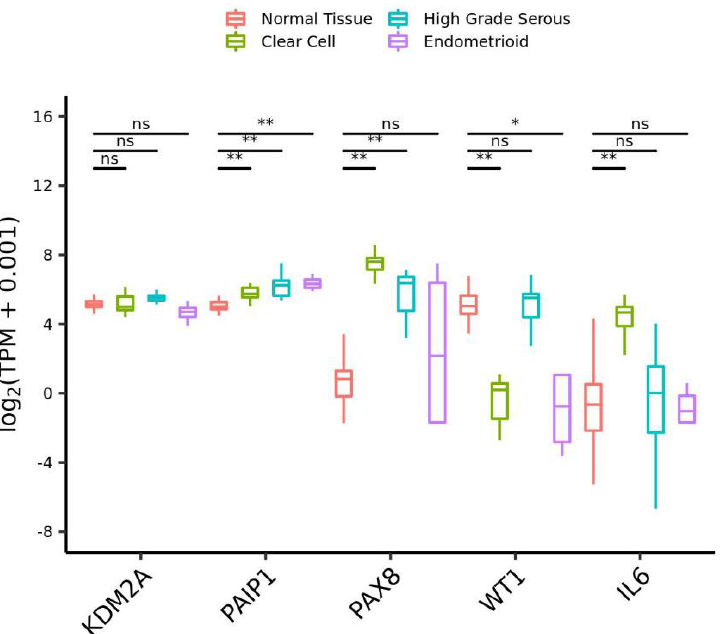
Figure 3. Quantification of KDM2A and PAIP1 expression from RNA-seq data. Normal tissue (from GTEx, n = 200) and ovarian cancer tissues prepared in our laboratory (clear cell carcinoma, n = 11; high-grade serous adenocarcinoma, n = 8; endometrioid carcinoma, n = 4.). PAX8, WT1 and IL6 are controls (PAX8 is known to be upregulated in ovarian cancer: PAX8 mRNA expression is 90- and 32-fold upregulated in clear cell carcinoma and high-grade serous adenocarcinoma, respectively, compared to normal tissue. PAX8 expression is ~2.7-fold upregulated in clear cell carcinoma compared to high-grade serous adenocarcinoma ( p = 0.025, Wilcoxson test). It has also been reported that PAX8 protein expression is upregulated in several ovarian cancer cell lines [35,36]. WT1 is downregulated and IL6 is upregulated in ovarian clear cell carcinoma). TPM, transcripts per million. * p <